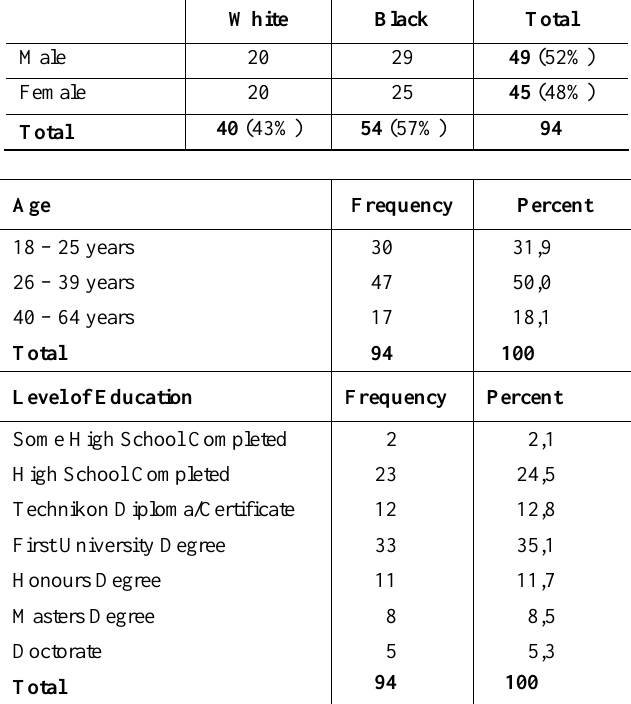
Table 1: Demographics of the